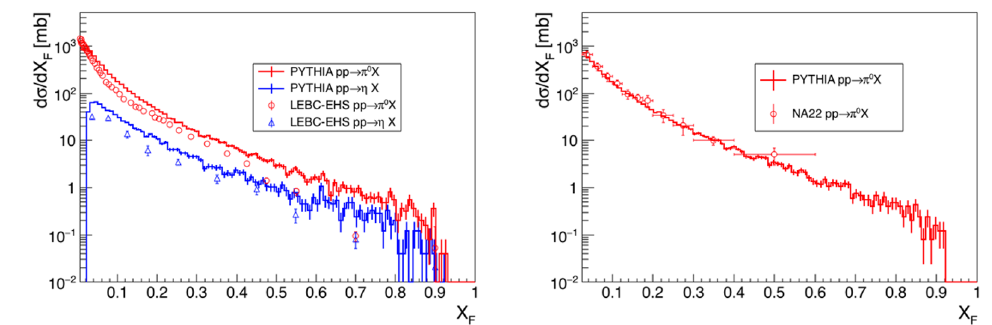
Figure 1 . Data-MC comparison of the di(cid:11)erential cross-section of neutral pions and eta mesons produced from 400 GeV (250 GeV) protons, to replace (cid:12)gure 3 (the right panel of (cid:12)gure 6) in JHEP 05 (2019) 213.